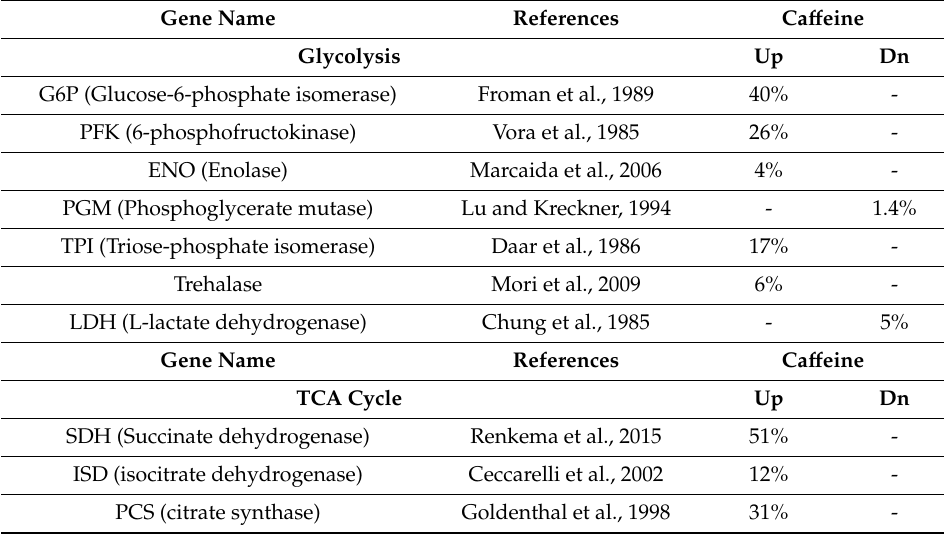
Figure 2. Caffeine inhibits DWV infection by promoting carbohydrate metabolism. ( A ) Relative changes in virus copy number in honeybees infected with DWV and in honeybees receiving caffeine diet prior to DWV infection. Mean and standard deviation (SD) values are shown, n = 6, and p -values were calculated using one-way Student’s t -test (* p < 0.05). WV: DWV virus infection; C/D: caffeine diet followed by DWV infection. Real-time PCR was used to quantitate the gene expression levels of metabolic enzyme genes involved in ( B ) glycolysis and ( C ) the TCA cycle after honeybees were fed with artificial feed containing caffeine. The relative expression rate of metabolic genes involved in the carbohydrate metabolism of honeybees is presented as a heat map. Clustering analysis was based on the Euclidean distance. For the caffeine treatment group in comparison to the control group, green represents a relative gene expression change <1.0 and red represents a relative gene expression change between 1.0 and 2.0. Table 3. Relative expression of carbohydrate metabolism in honeybees of mixed group. The results were done by real-time PCR. The values in the table represent how much percent the relative gene expression level up-/down-regulated than control group in caffeine only treatment group. Statistical analysis was undertaken by one-way ANOVA followed by Tukey’s post-hoc test. Asterisks indicate p -values < 0.05.